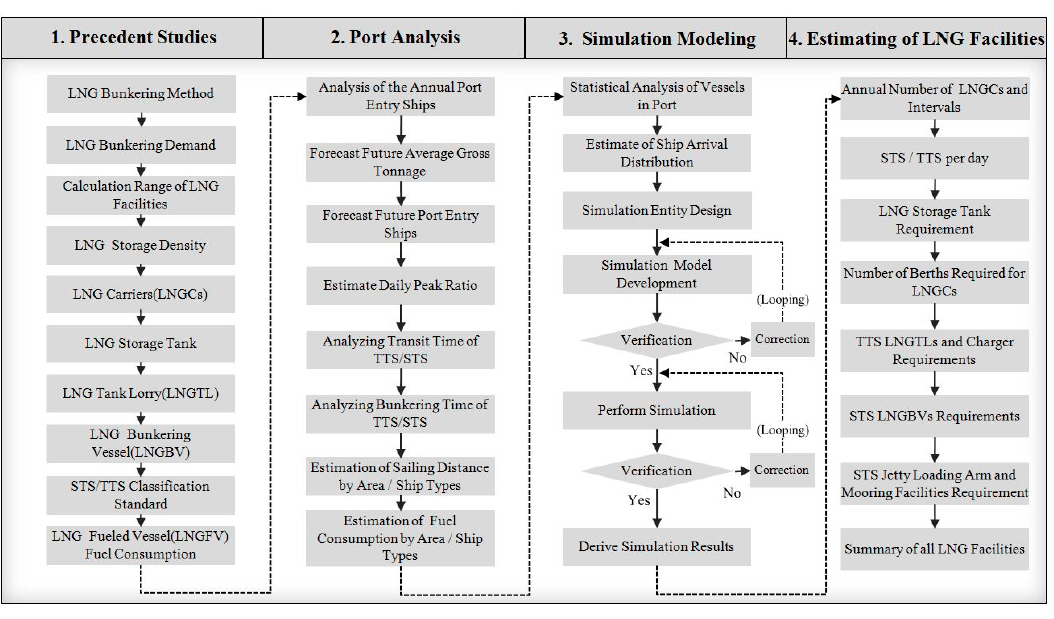
Figure 1. Research Procedure.